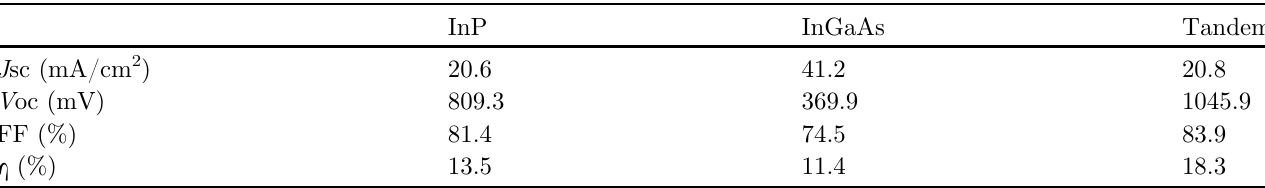
Table 3. Main PV parameters of the tandem cell compared with those of the two single-junction individual cells.